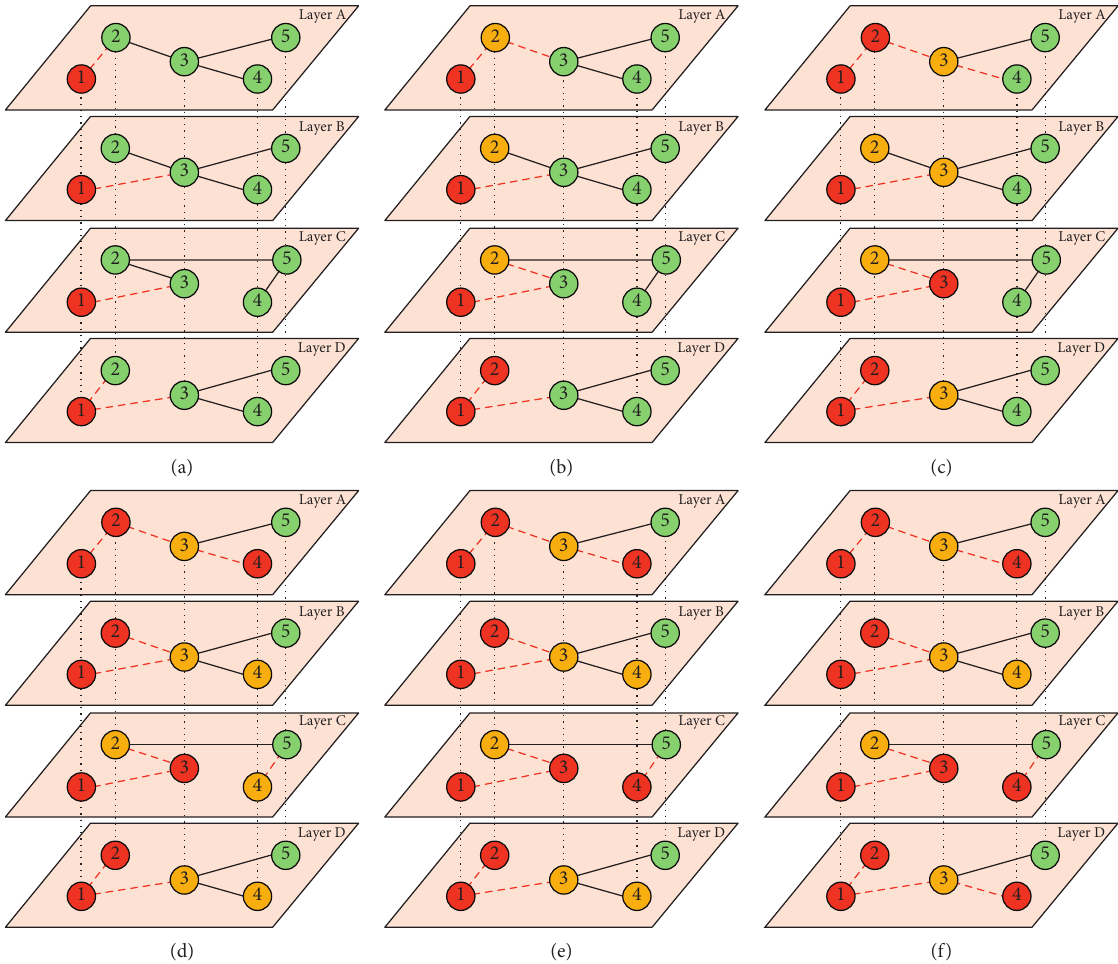
Figure 1: Schematic diagram of the cascading process in a four-layer network. The nodes in different layers with the same Arabic number are replica nodes, and they are connected by dotted lines. The funtional links are marked in solid lines and the failed links are marked in dashed lines. The functional nodes are marked in green, the failed nodes are marked in red, and the yellow nodes are still viable after being damaged. At stage (A), the replicas with the Arabic number 1 are removed from all layers. At stage (B), the node (2, D ) becomes isolated from the giant component in layer D and fails, which leads to the link removal of its replicas in layers A , B , and C . At stage (C) the node (3, C ) becomes isolated from the giant component in layer C and fails, which leads to the link removal of its replicas in layers A , B , and D . Simultaneously, node (2, A ) becomes isolated and fails due to the removal of link 23 in layer A , which further leads to the link removal of its replicas in layers B and C . At stage (D), the node (4, A ) becomes isolated from the giant component in layer A and fails, which leads to the link removal of its replicas in layers B , C , and D . Simultaneously, node (2, A ) becomes isolated and fails due to the removal of link 23 in layer B . At stage (E), the node (4, C ) becomes isolated from the giant component and fails, which leads to the link removal of its replicas in layers B and D . At stage (F), the node (4, D ) becomes isolated and fails, and the system reaches the final steady state. (a) Stage A. (b) Stage B. (c)